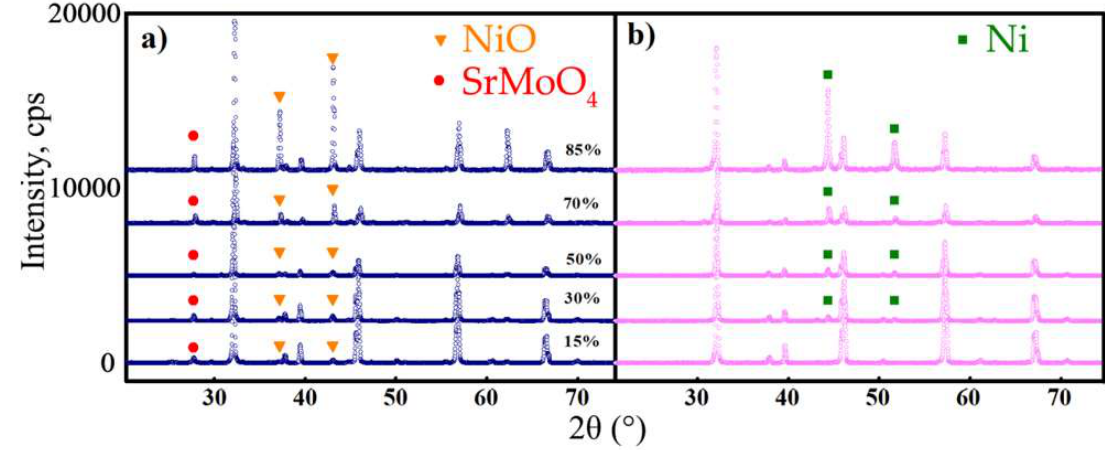
Figure 1. XRD data for the (1 − x)Sr 2 Mg 0.25 Ni 0.75 MoO 6 − δ + xNiO composite materials obtained after ( a ) sintering in air at 1350 ◦ C and ( b ) reducing in 50%H 2 / Ar mixture at 800 ◦